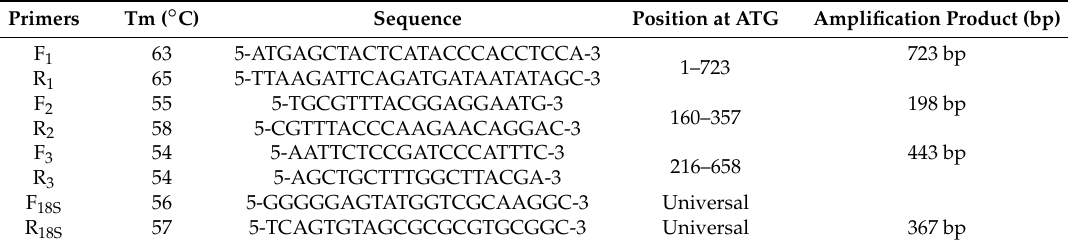
Table 1. Primers used in this